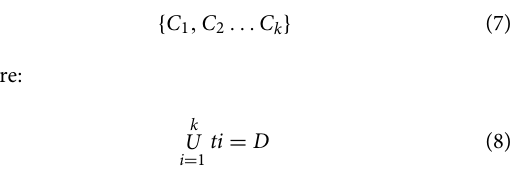
Clara algorithm and clarans algorithm. The classical